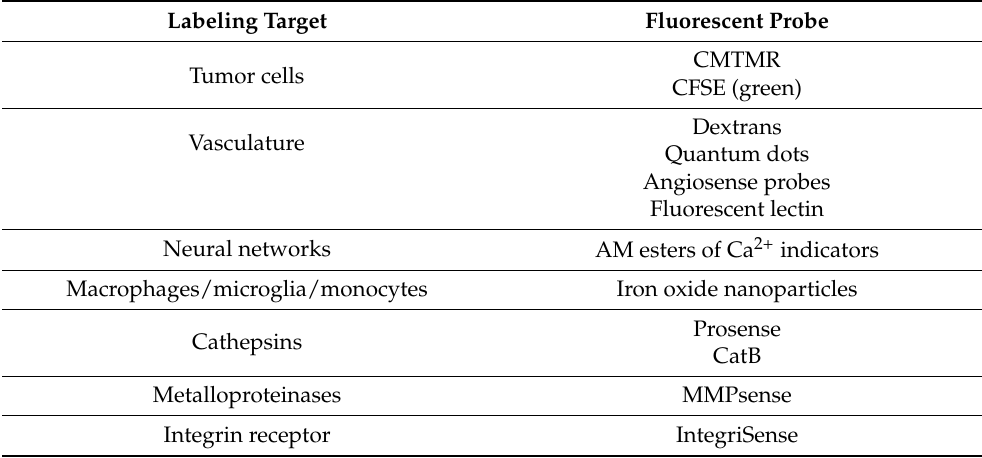
Table 1. Summary of commonly used fluorescent probes for two-photon intravital